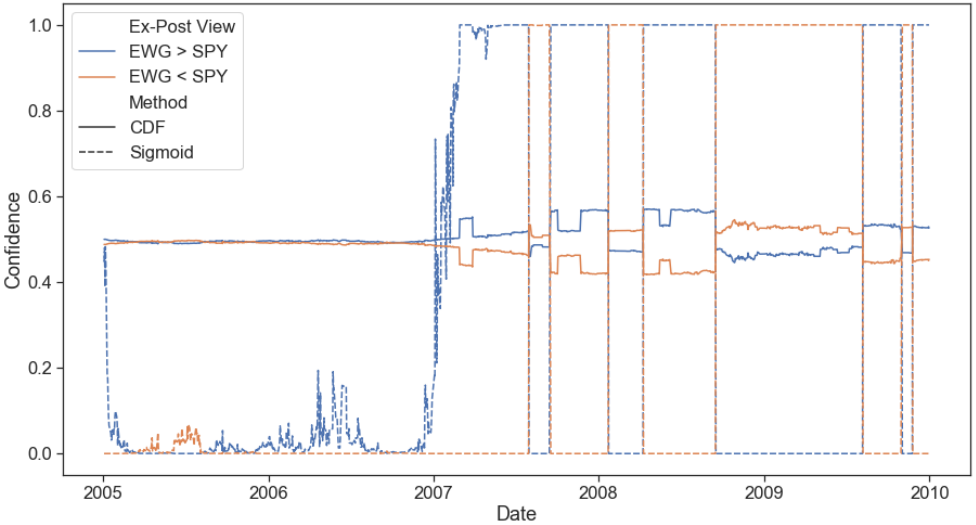
Figure 11. Dynamic View Confidence